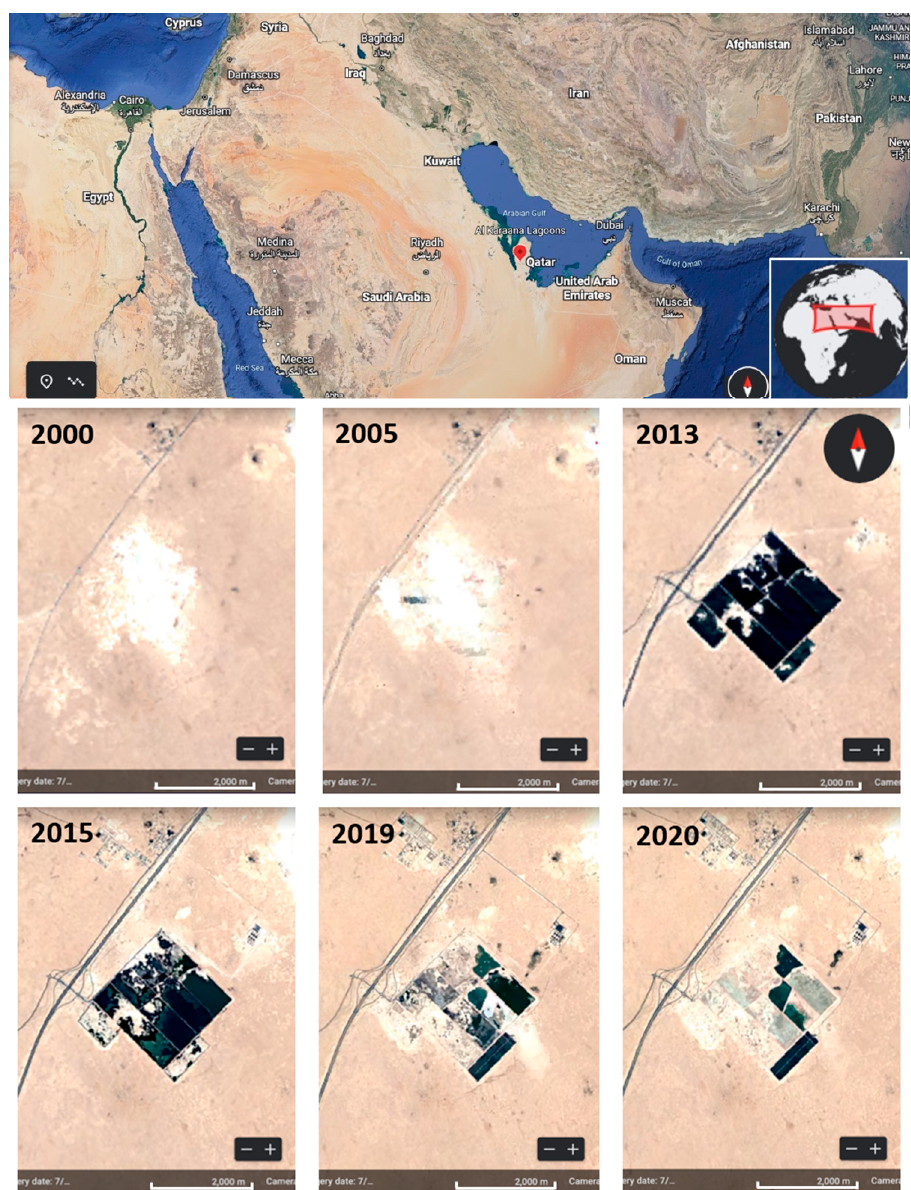
Figure 1. Satellite photos showing the Al Karaana Lagoons area, obtained from Google Earth and Google Earth’s timelapse function: top, showing the geographic location of the Al Karaana Lagoon area (red pin, September 2022, scale bar 600 km); bottom, set of six photos showing the relatively undisturbed state in 2000–2005, the full extent of the area for untreated waste in 2013 and 2015, rehabilitation in progress in 2019, and after rehabilitation in 2020 (scale bar 2000 m). In lower panels labeled with the year, white to tan colors are the compact sandy desert habitat. Dark colors are water, either untreated wastewater (before 2019) or treated wastewater (2020). The road lying north and west of the study site is Salwa Road or Highway no. 5.